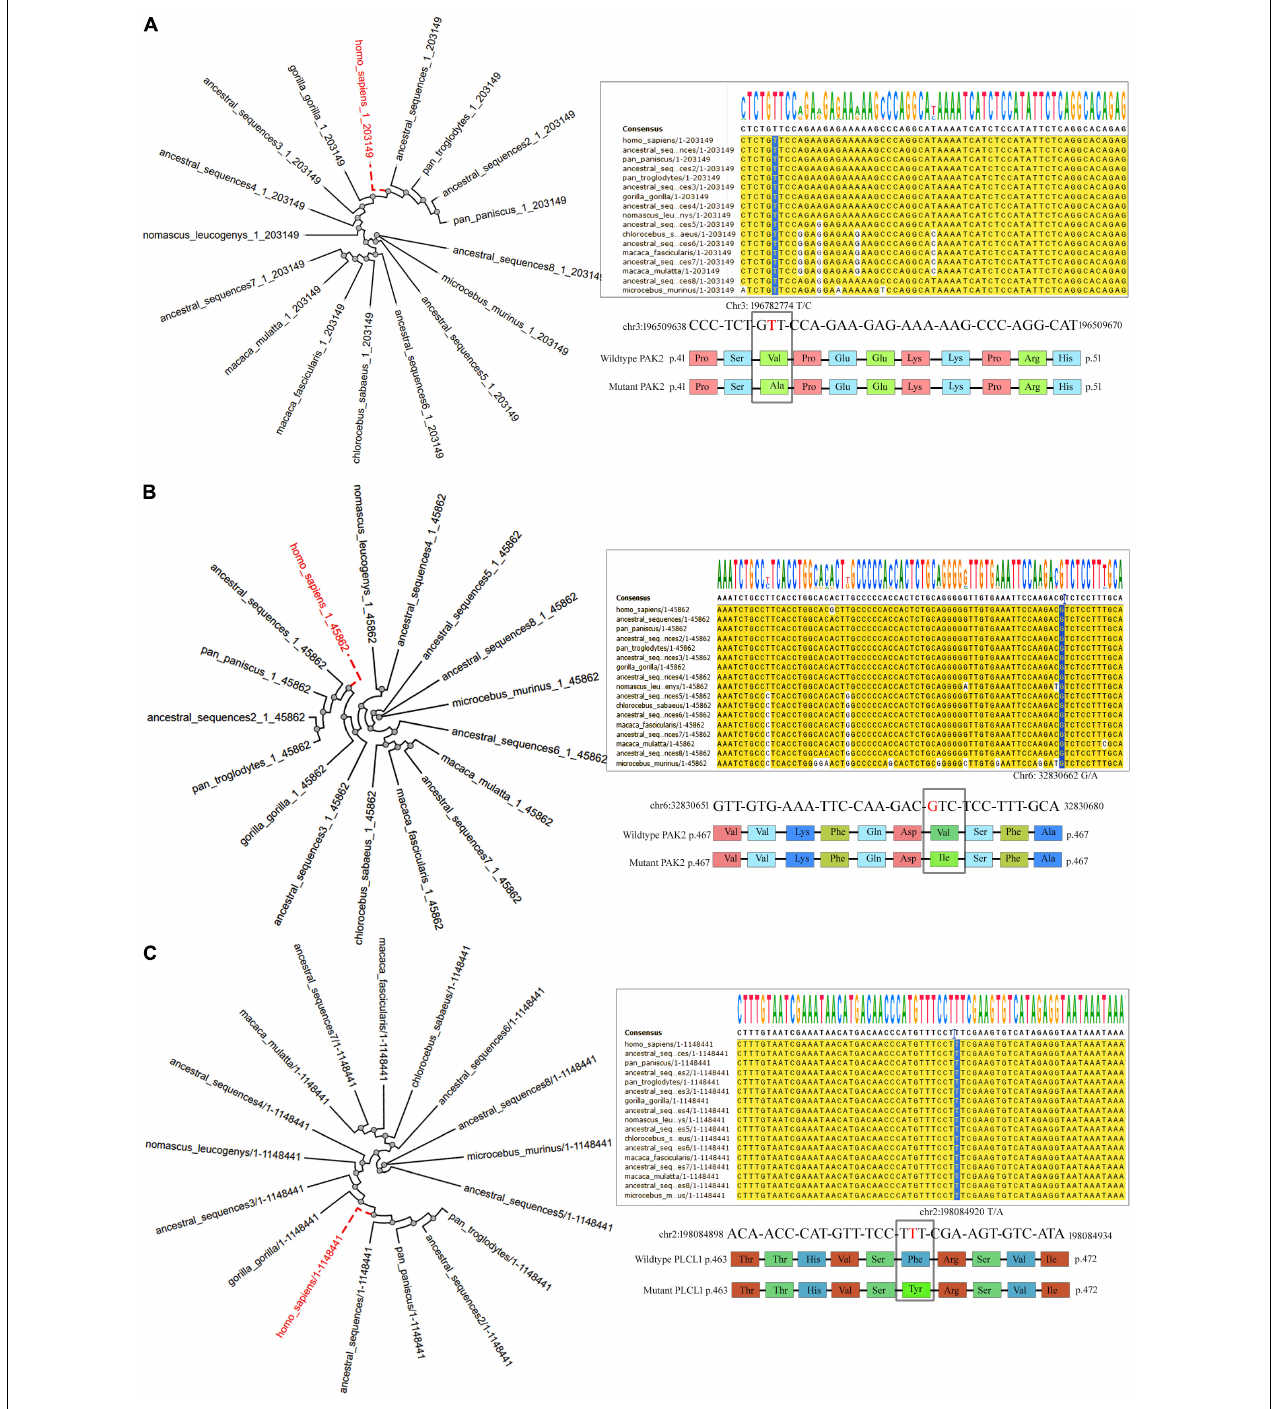
FIGURE 4 | The Phylogenetic tree and nucleotide sequence alignment showing the location of missense variants of the PAK2 (A) , TAP2 (B) , and PLCL1 (C) genes across 13 primates.